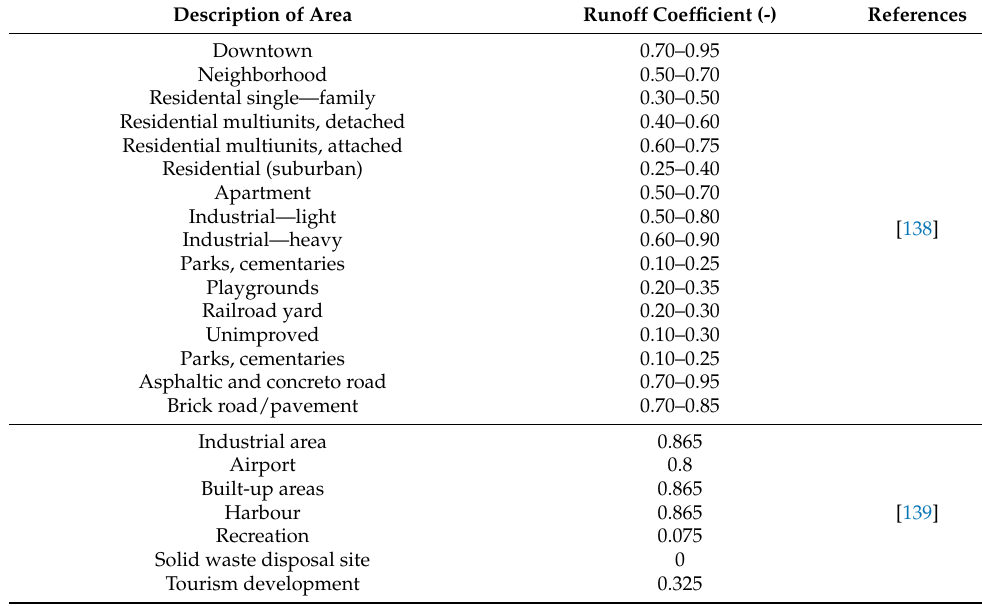
Table 3. Exemplary values of runoff coefficient for various